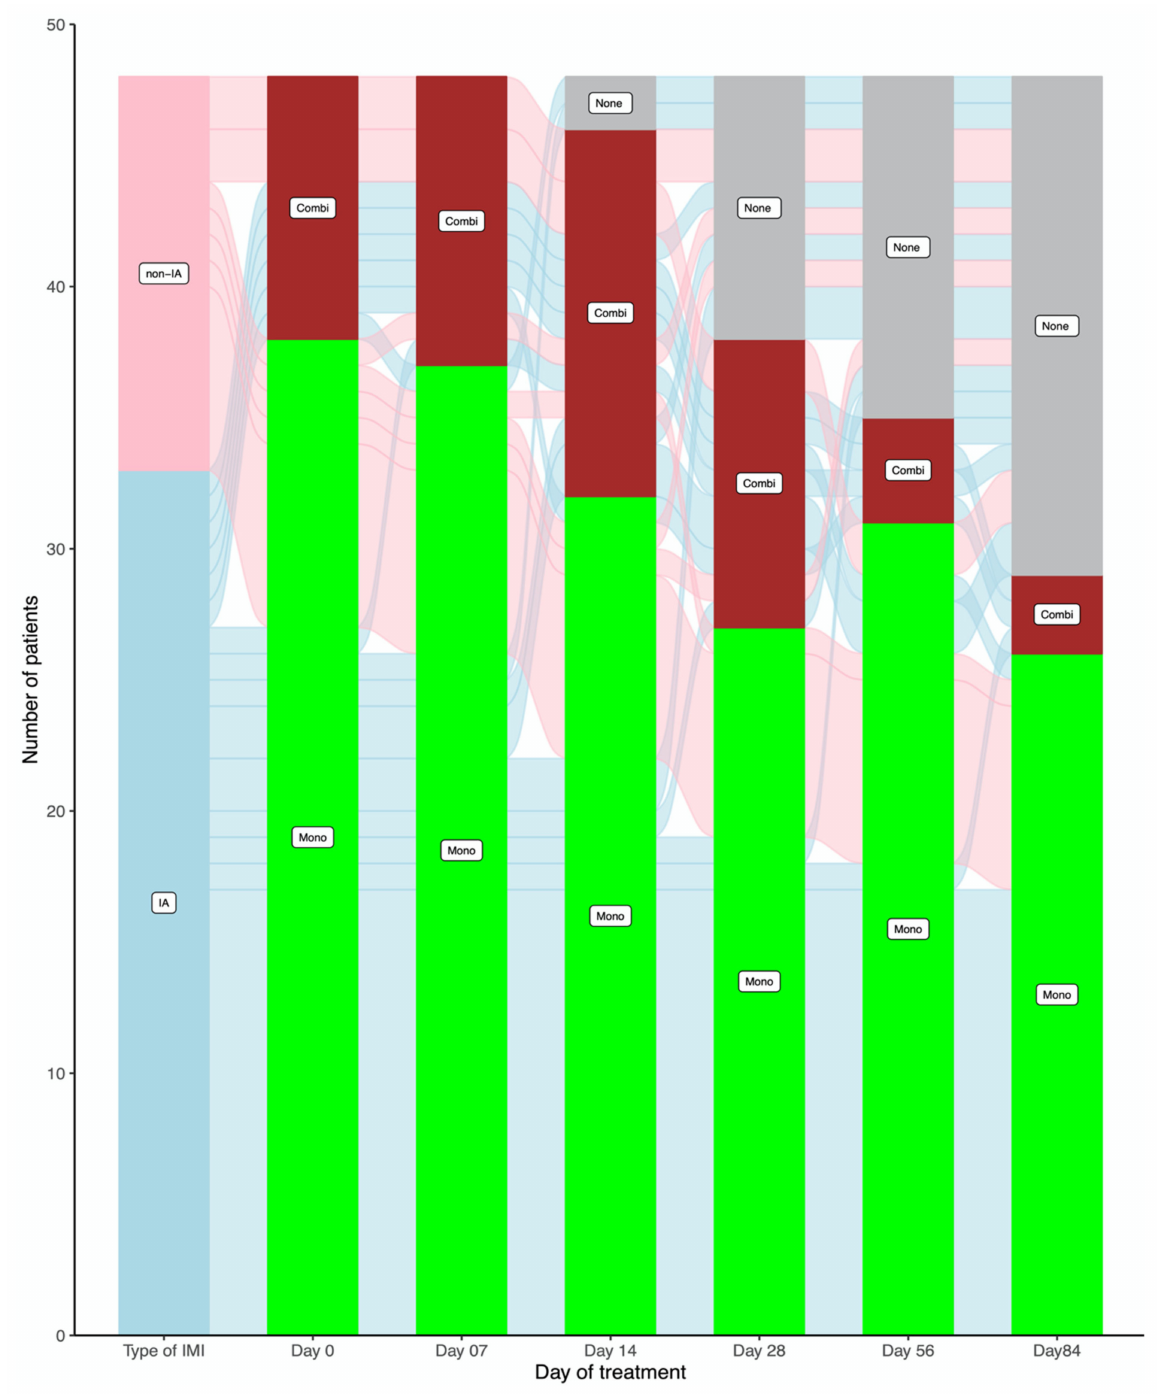
Figure 1. Alluvial plot summarizing the administration of antifungal therapy and treatment changes between monotherapy and combination antifungal treatment from baseline and during the first 12 weeks after the diagnosis of an invasive mold infection. IMI: invasive mold infection, IA: invasive aspergillosis, non-IA: non-IA IMI, Mono: monotherapy, Combi: combination therapy, None: no